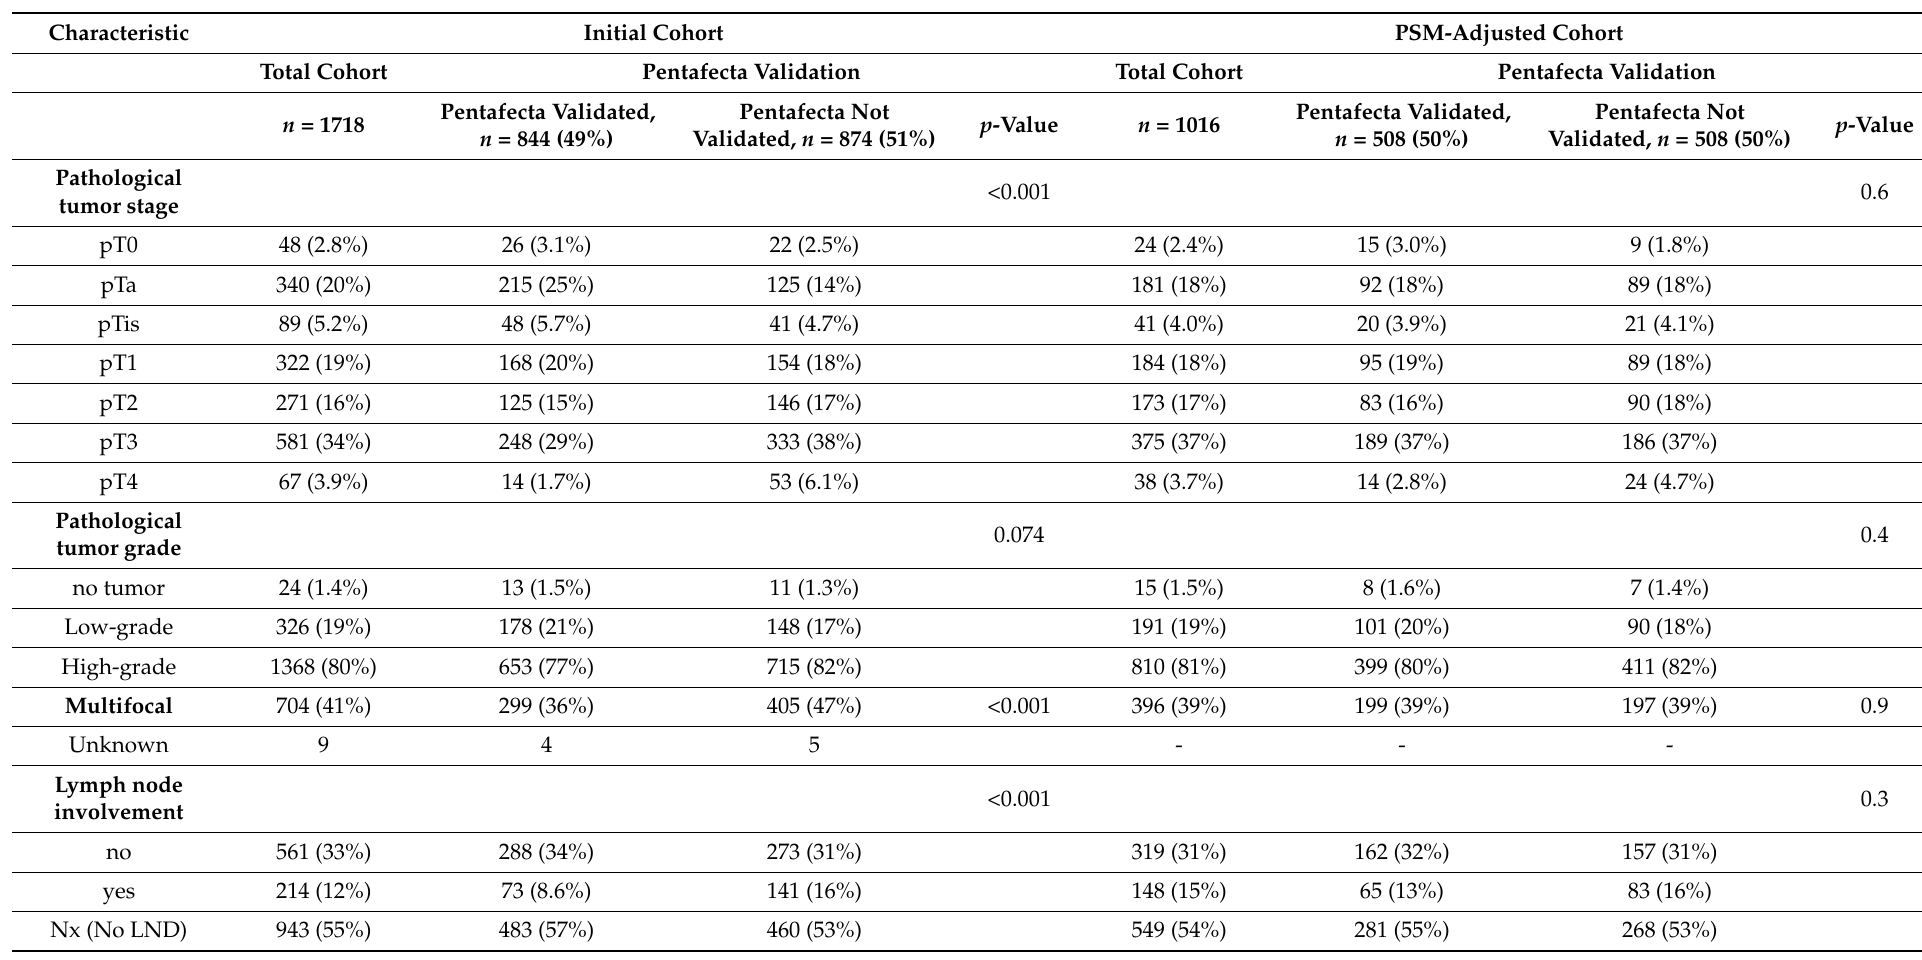
Table 3. Pathological characteristics of 1718 patients treated with RNU for high-risk UTUC, initial cohort ( left ) and after propensity-score-matching adjustment ( right ), both stratified by pentafecta validation. PSM = propensity-score matching; IQR = interquartile